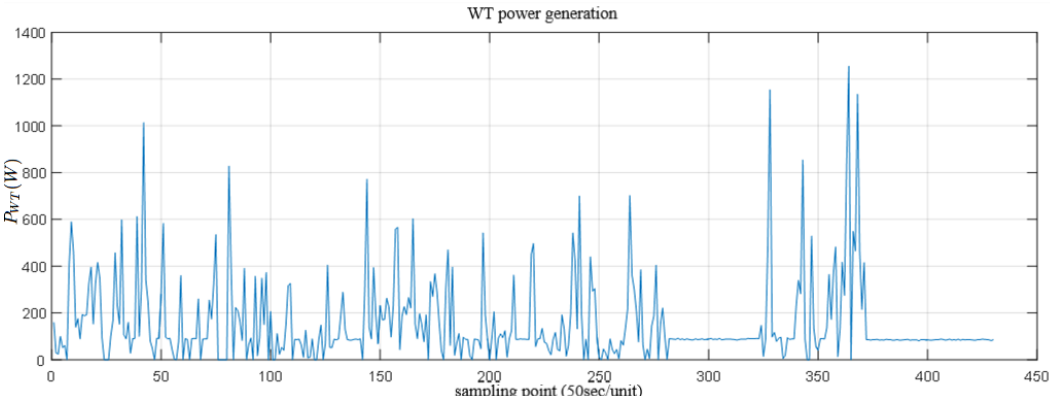
Figure 8. Wind turbine generator power and energy deployment.